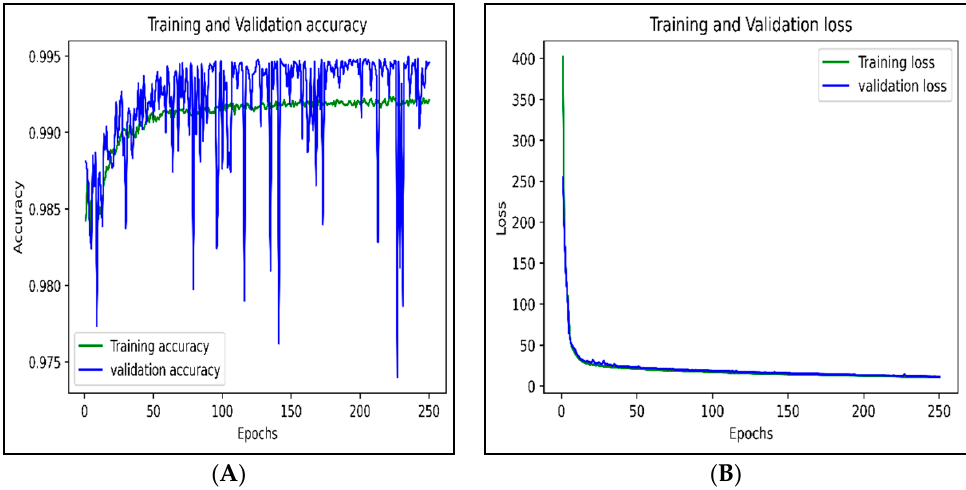
Figure 19. ( A,B ): Accuracy and Loss curves for Friday morning sub-dataset. Figure 19. ( A , B ): Accuracy and Loss curves for Friday morning